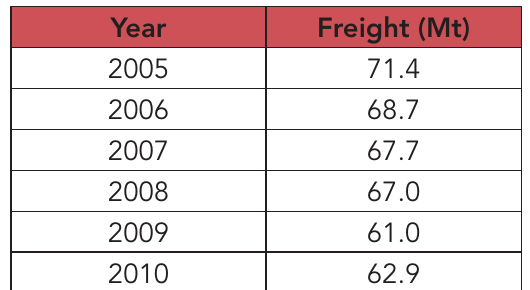
Table 2: Coal shipment by Transnet 2005-2008 Source: Compiled from various sources